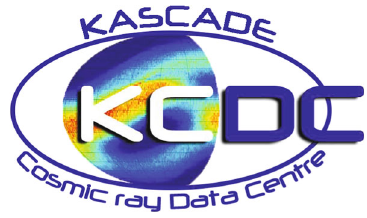
Fig. 1 Logo of KCDC (https://kcdc.ikp.kit.edu)